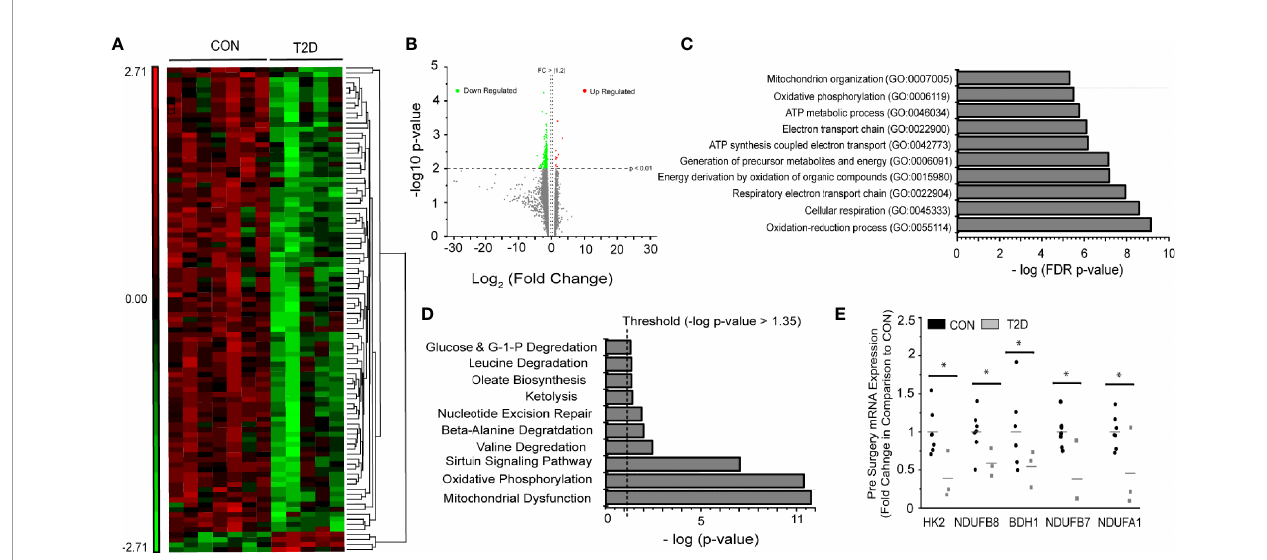
FIGURE 1 | Pre-surgery skeletal muscle gene expression in T2D vs. CON. (A) Heat map (probe intensities) of 97 signi fi cantly (p < 0.01; FC > |1.2|) probes used for biological function and pathway analysis. (B) Volcano plot of 25,839 probes used for statistical analysis. Green (Down Regulated) and Red (Upregulated) of 97 signi fi cant ( p < 0.01, FC > |1.2|) probes for Pre-Surgery skeletal muscle T2D vs. CON. (C) Gene Ontology Enrichment analysis for biological process of differentially expressed genes in individuals with and without diabetes pre-surgery. (D) Signi fi cant pathways from Ingenuity Pathway Analysis using the Canonical Pathway tool. Presented pathways are overrepresented with genes differentially regulated between those with and without diabetes. (E) Fold changes in select genes as determined via qPCR; * p < 0.05 students